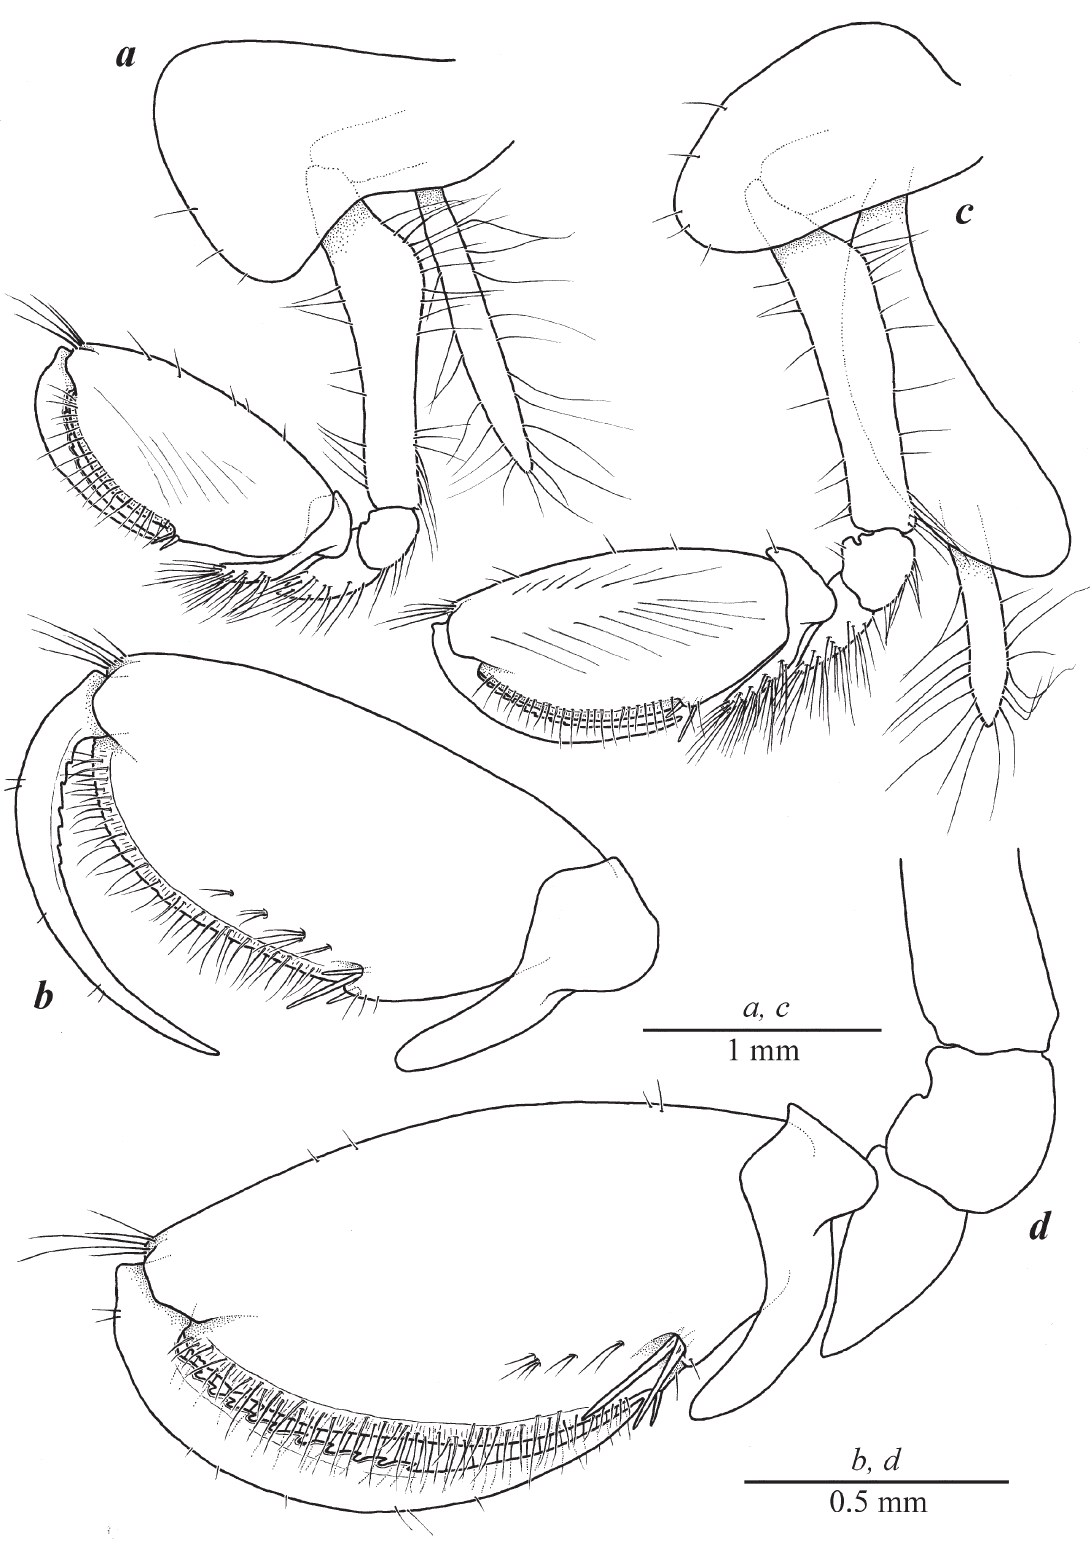
Fig. 3. Liljeborgia associata sp. nov., female (LEMMI) from Vostok Bay of the Sea of Japan. a . Gnathopod 1. b . Chela of Gn1 . c . Gnathopod 2. d . Chela of Gn2